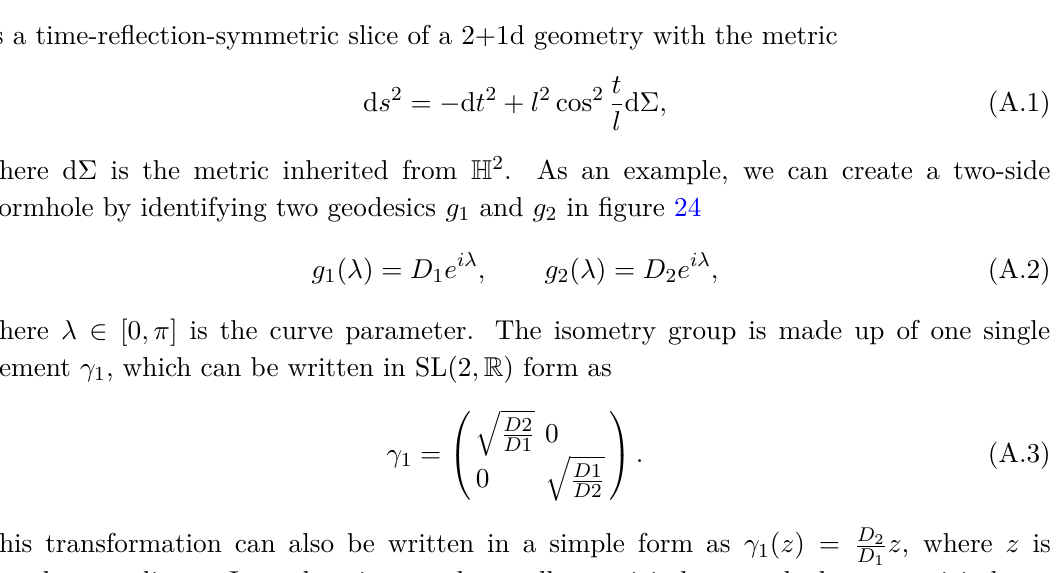
Figure 24 . The covering space construction of a 2-side wormhole. The geodesics g 1 and g 2 are identified. The blue dashed circle M is the causal horizon and R 1 and R 2 are two asymptotic bound-